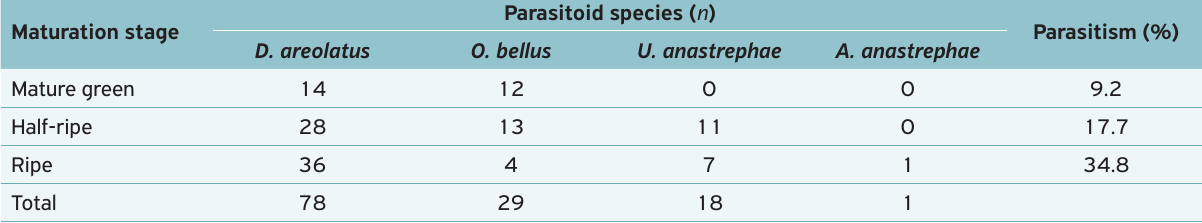
Table 3. Number and parasitism rate of parasitoid species, emerged from fruit fly puparia from three maturation stages of Surinam cherry. Maceió, Alagoas, from October 2010 to January 2011.